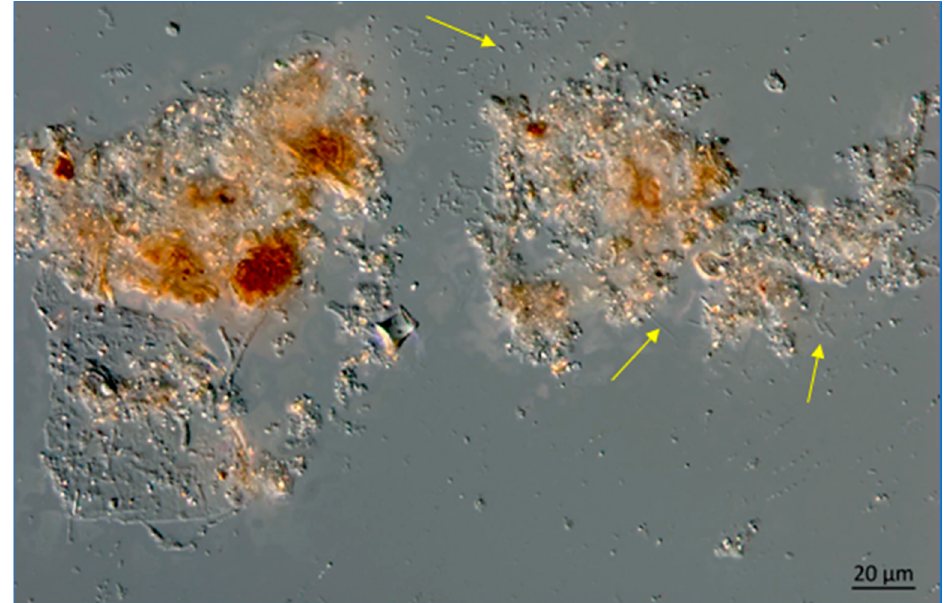
Figure 14. Lake Okeechobee snow from a 3.2 m depth, June 2020. Note the presence of filamentous bacteria at arrows. The image was obtained using a Zeiss AX10 microscope equipped with DIC and a digital imaging system.